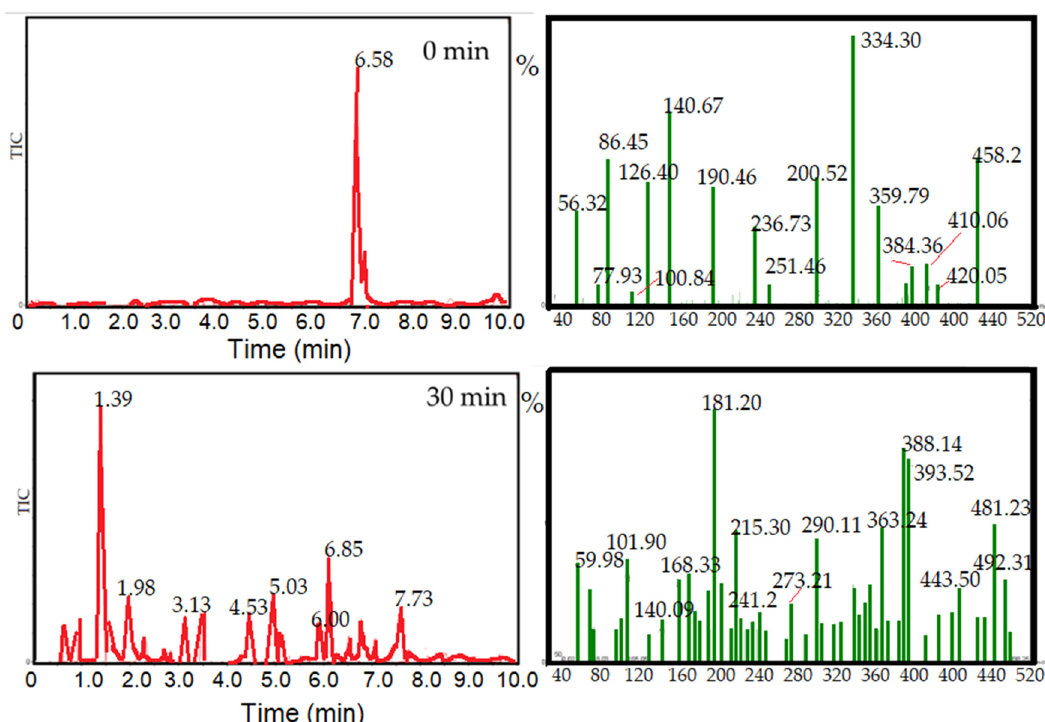
Figure 11: LCMS analysis of initial RhB and treated solution for 30 min: [ Rhb ] 0 = 20 mg · L − 1 , time of treatment = 30 min, [ H 2 O 2 ] = 1 mL, light = UV, and photocatalyst dose = 0.5 g · L − 1